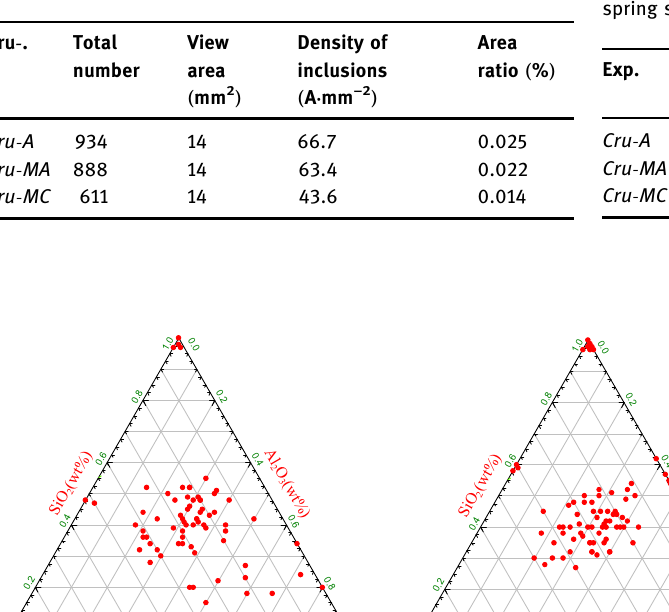
Table 5: Statistical results of inclusions in 55SiCr suspension spring steel Table 6: The equivalent diameter distribution of inclusions in 55SiCr